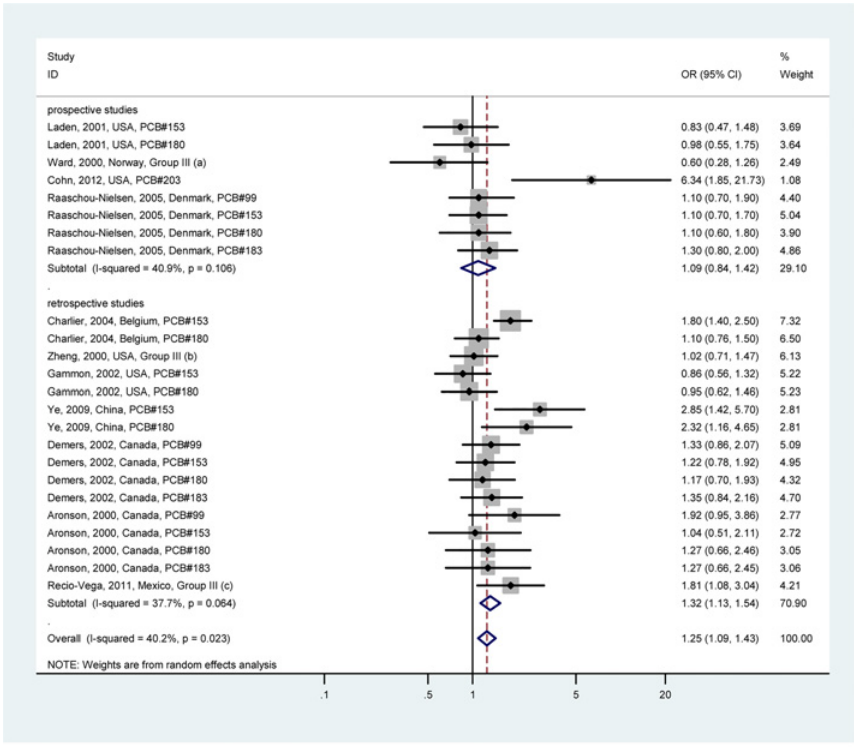
analysis, the subgroup analyses on prospective (upper panels) and retrospective (lower panels) studies are presented. (a) Group III includes 153, 180 and 183; (b) Group III includes 153, 180, and 183; (c) Group III includes congeners 153 and 180.